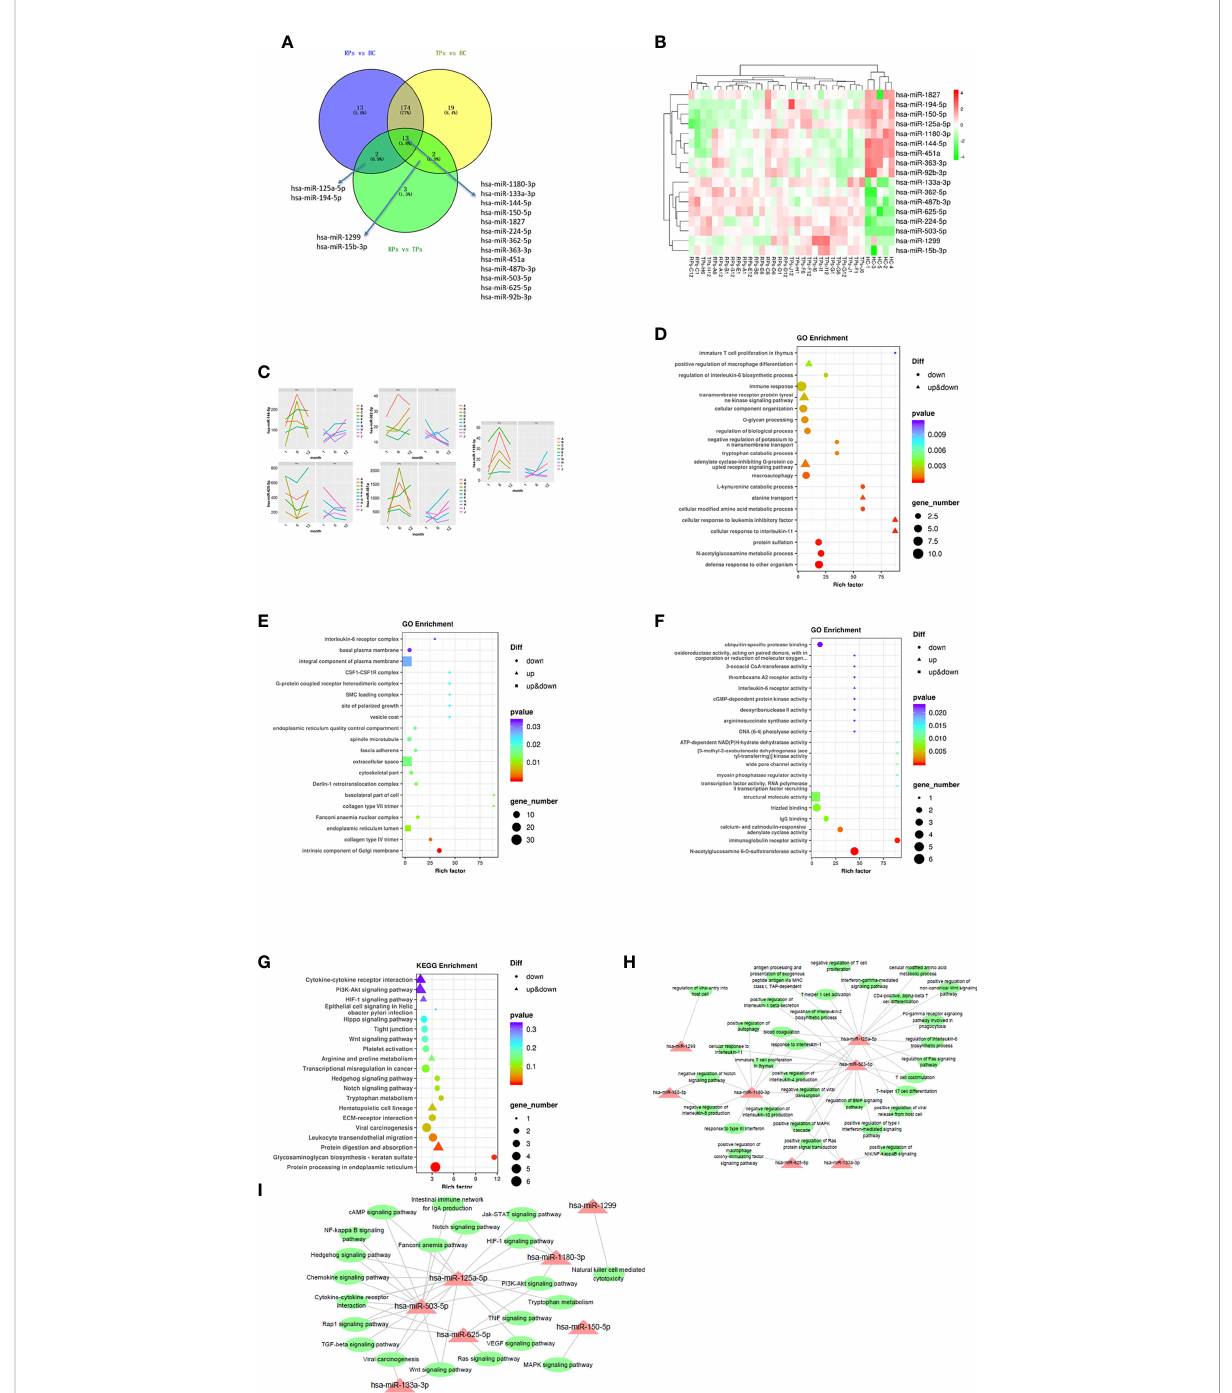
FIGURE 4 The analysis of key differential exosomal miRNAs and their variation tendency. (A) Venn plot showing differently expressed miRNAs between TPs and RPs at 1, 6, and 12 months. (B) The heatmap indicated 17 differently expressed miRNAs between RPs, TPs, and HC groups. (C) We depicted fi ve miRNAs expression variations in TPs and RPs at 1, 6, and 12 months. (D – F) The GO terms interpretation for the functions of these 208 differential miRNAs. (G) The KEGG terms interpretation for the functions of these 208 differential miRNAs. (H) The miRNA target interaction regulatory network form GO terms. (I) The miRNA target interaction regulatory network form KEGG